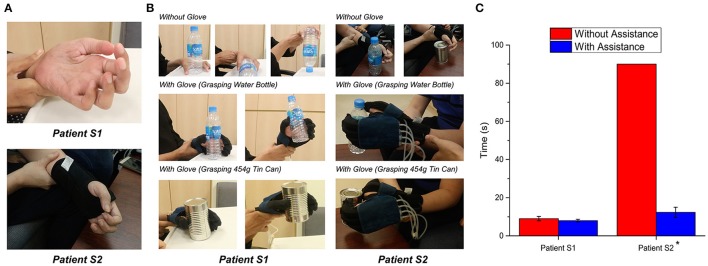
Evaluation of the glove with stroke patient S1 and S2. (A) Hand conditions of patients. (B) Comparison of grasping performances with and without assistance of glove. (C) Time taken to complete the grasping tasks (n = 6 for each patient; P = 0.06 for S1, P = 0.02 for S2, paired t test, *p < 0.05.). The actuators of the glove were pressurized at 120 kPa.